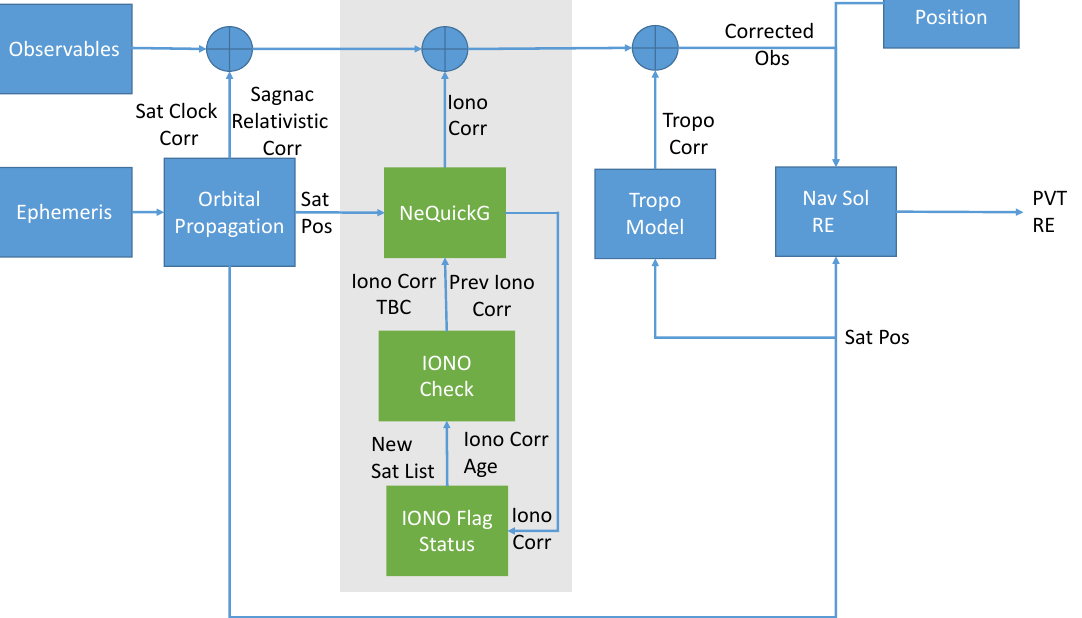
Figure 1. Schematic representation of the processing adopted for evaluating the impact of the update rate on computing the ionospheric